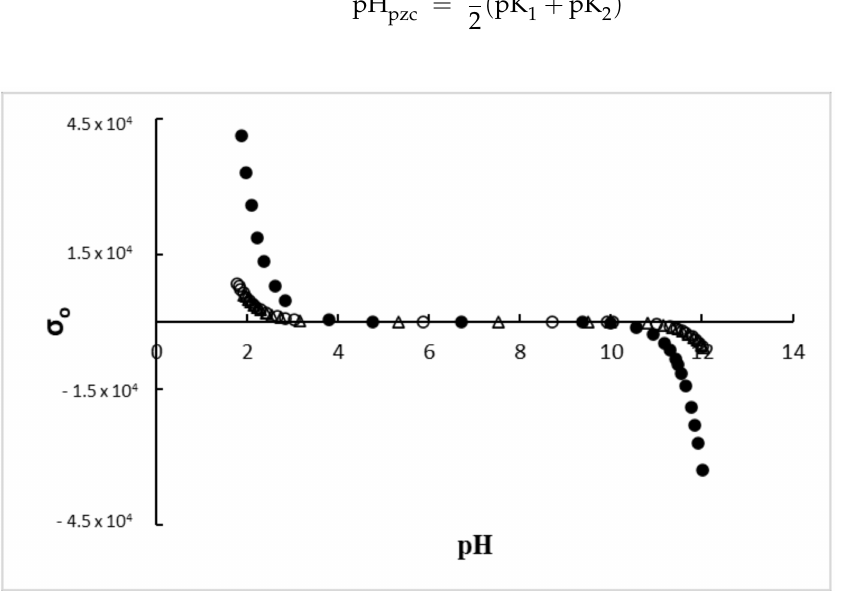
Figure 3. Surface charge density of studied catalysts. Filled circles ( • ) represent the S0-catalyst, the open circle (o) the S1-catalyst suspension, while open triangle ( ∆ ) the S2-catalyst suspensions.